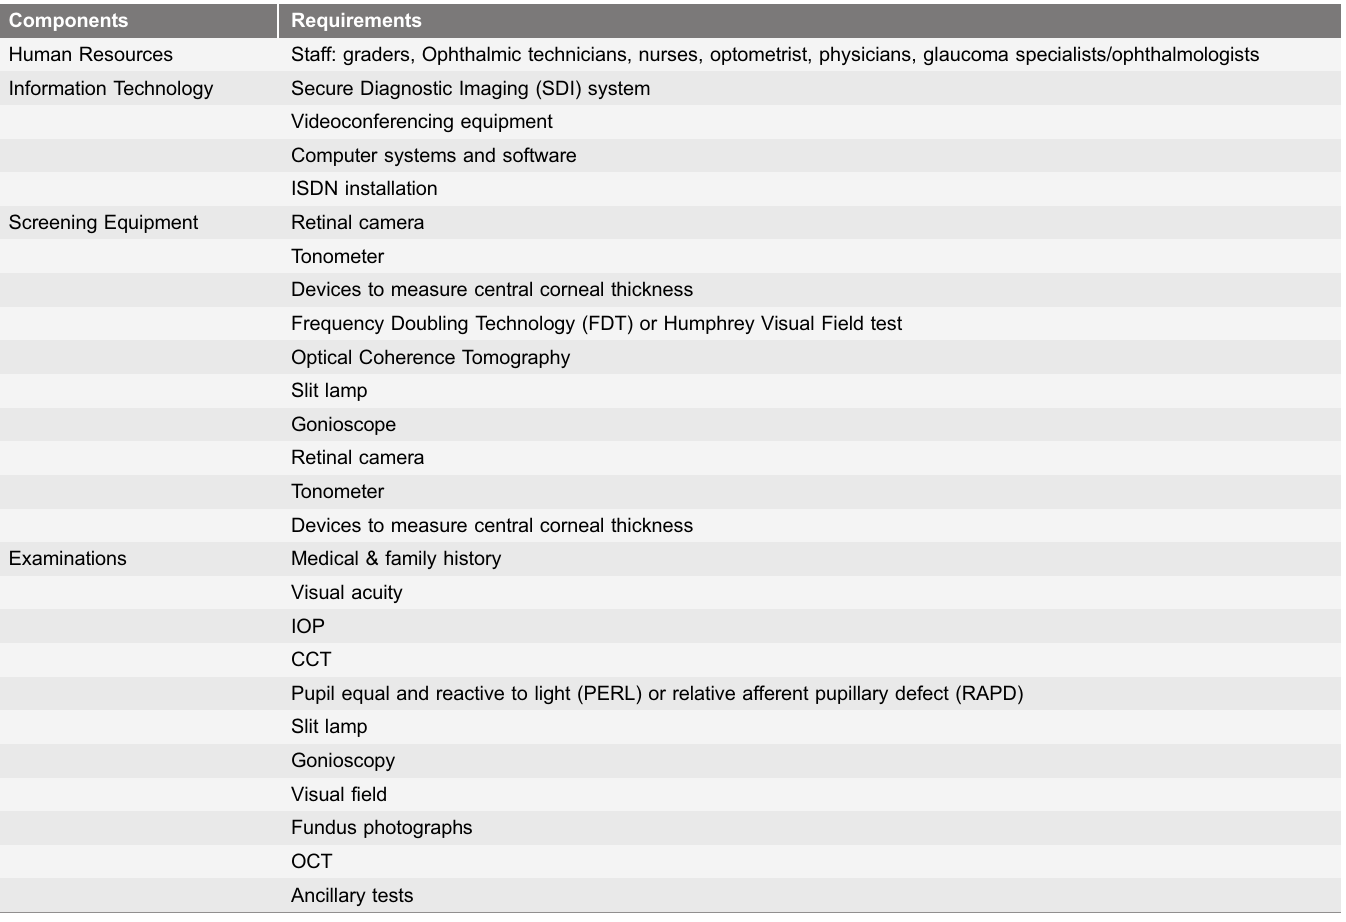
Table 1. Standardized teleglaucoma